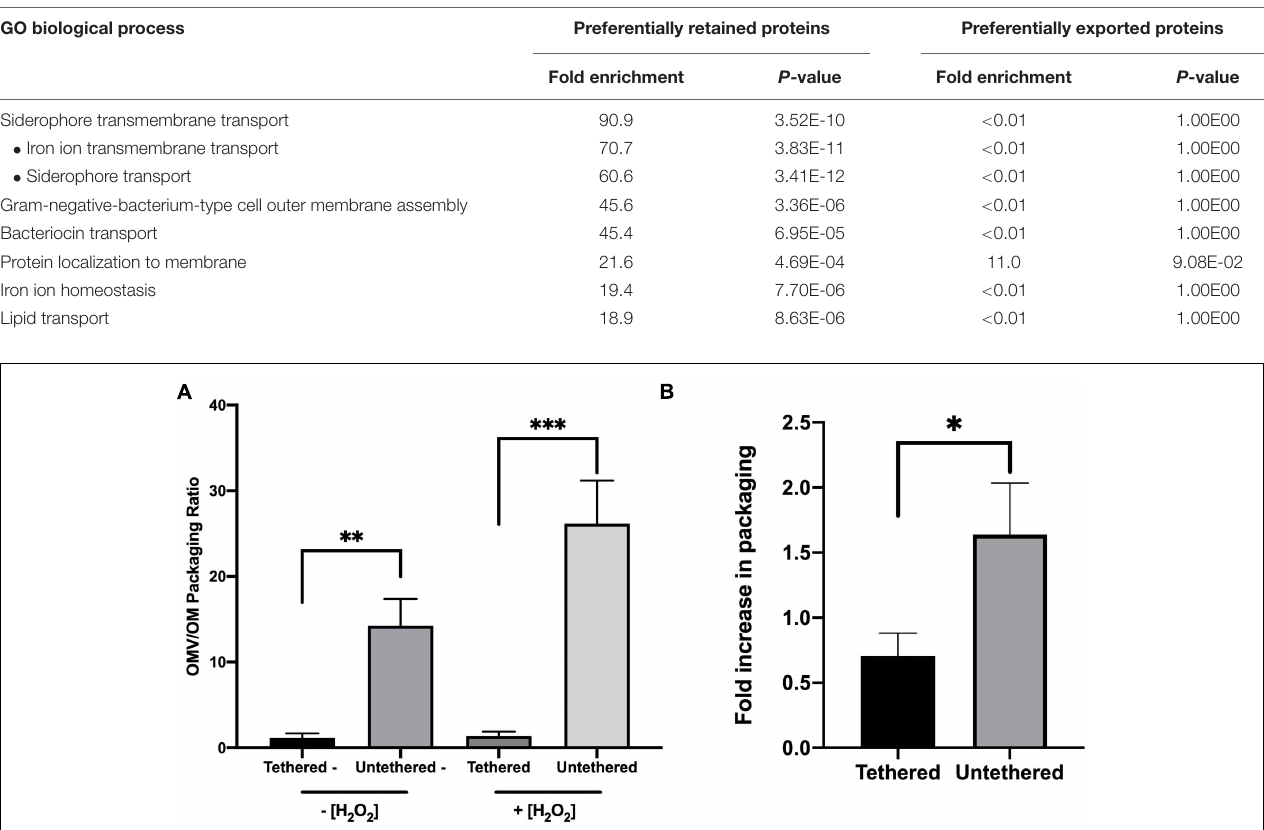
TABLE 1 | Preferentially retained OM-associated proteins are enriched in transport and iron homeostasis GO categories. GO biological process